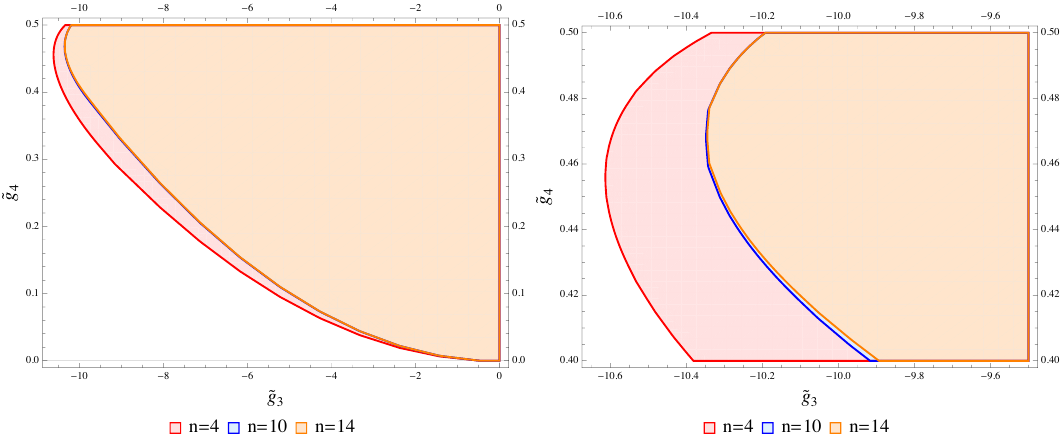
Figure 10. Convergence of the (˜ g 3 , ˜ g 4 ) allowed region (shaded) with the Mandelstam degree n of crossing equations. The positive section of the horizontal axis is omitted since that region converges